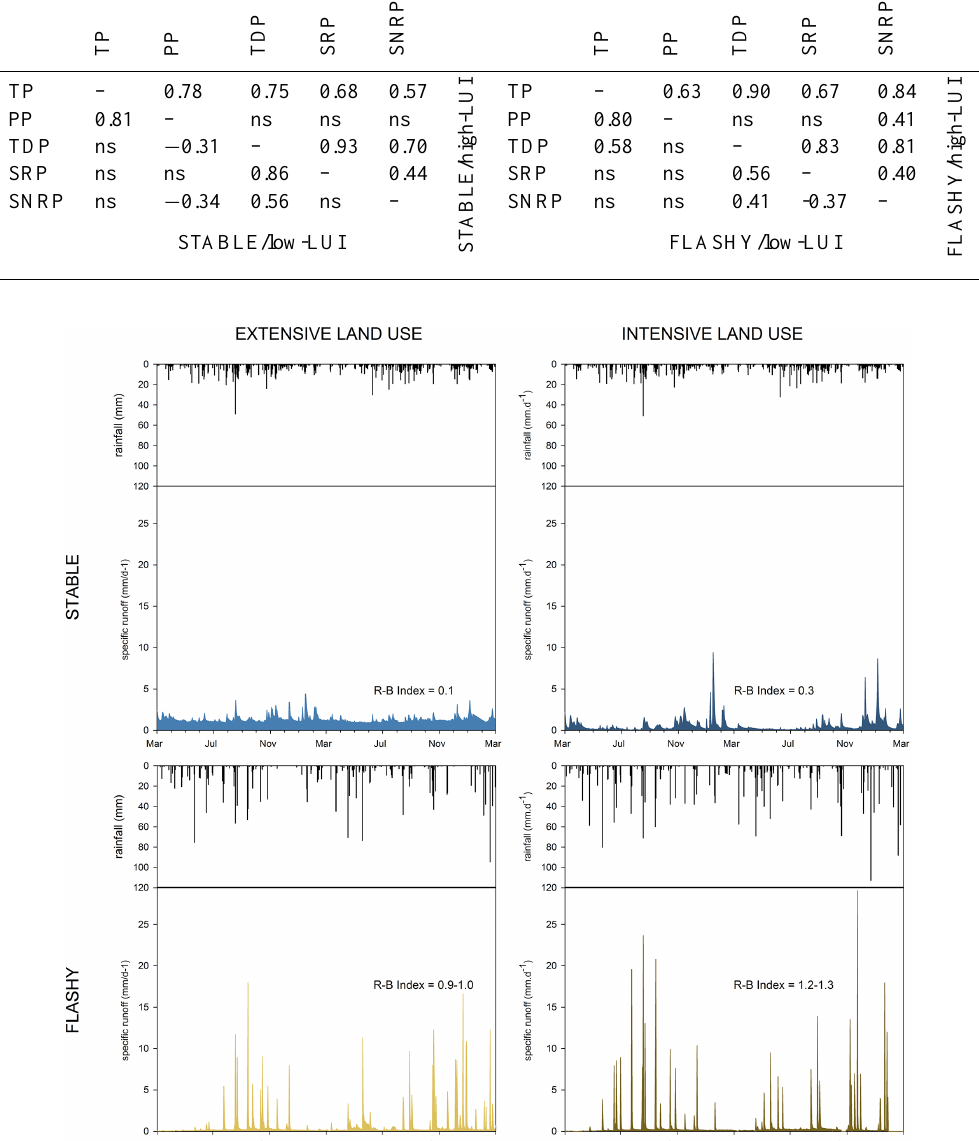
Table 3. Correlation matrices of total (TP), particulate (PP), total dissolved (TDP), soluble reactive (SRP), and soluble non-reactive (SNRP) phosphorus from instantaneous-grab samples. Upper and lower triangles of each matrix refer to high- and low-LUI conditions, respectively. Numeric values represent Spearman rank order correlation and were included only when significant ( p ≤ 0.05). ns: non-significant. STABLE: low-flashiness Danish streams; FLASHY: Uruguayan flashy streams; low- and high-LUI: low and high land use intensity.